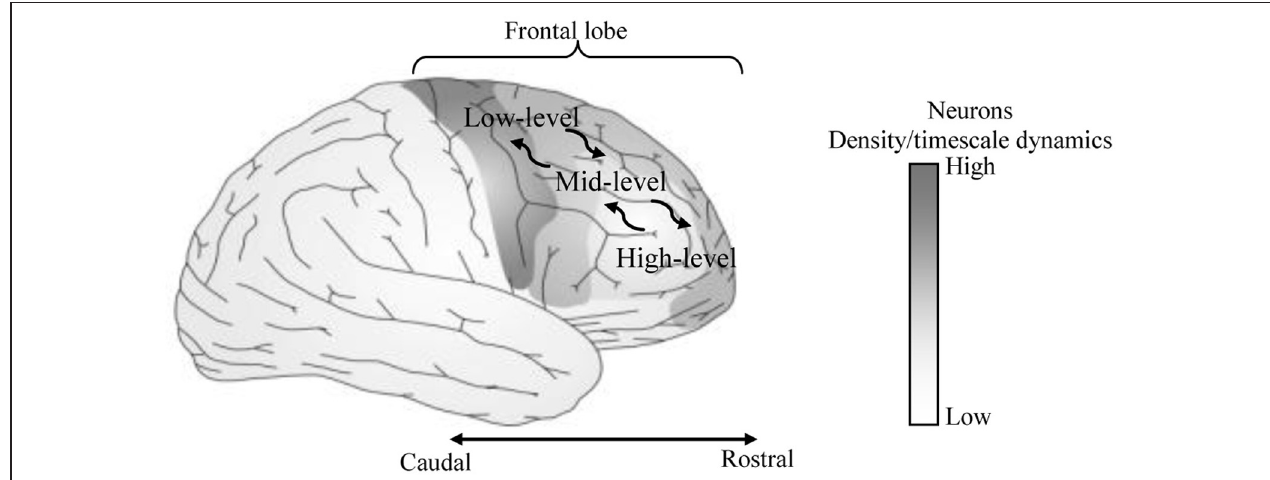
FIGURE 1 | Anatomical sites of area of our focus on the human brain. The most anterior regions show lower number of neurons and slower neural timescale dynamics than the most posterior